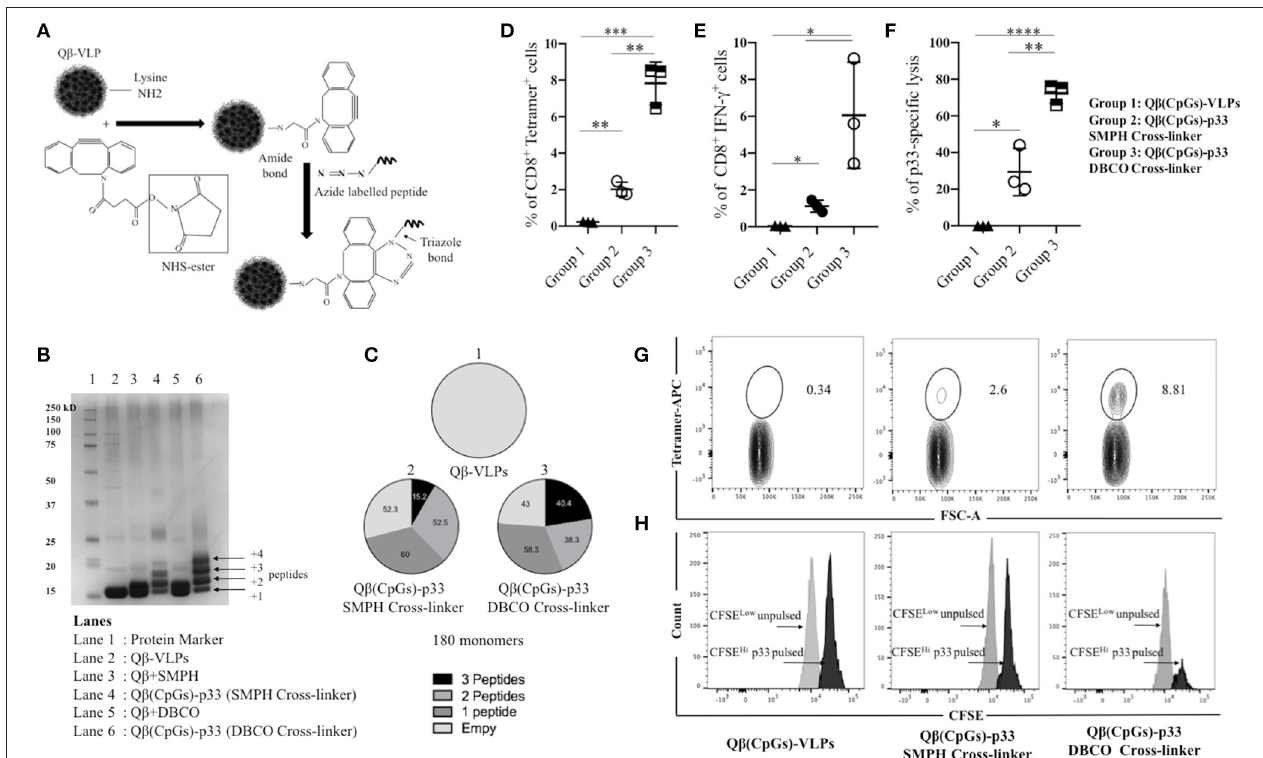
FIGURE 2 | Bio-orthogonal Cu-free click chemistry; an efficient method for coupling antigens to VLPs to enhance their immunogenicity. (A) A sketch illustrating the coupling method using Bio-orthogonal Cu-free click chemistry (dibenzocyclooctyne NHS ester DBCO). Briefly, NHS ester reacts with Lys residues on VLPs and incorporates a cyclooctyne moiety which reacts with the azide labeled molecule forming a stable triazole linkage. (B) SDS-PAGE stained with coomassie blue showing the coupling efficiency of p33 to Q β (CpGs)-VLP using SMPH cross-linker or DBCO cross-linker. Lane 1 protein marker, lane 2 Q β -VLP monomer, lane 3 Q β (CpGs)-VLP derivatized with SMPH cross-linker, lane 4 Q β (CpGs)-p33 vaccine using SMPH cross-linker, lane 5 Q β (CpGs)-VLP derivatized with DBCO cross-linker, lane 6 Q β (CpGs)-p33 vaccine using DBCO cross-linker. Each extra band in lanes 4 and 6 indicates a peptide binds to a Q β monomer. (C) Densitometric analysis of SDS-PAGE lanes 1, 4, and 6. (1) uncoupled Q β -VLP, total 180 monomers, (2) Q β (CpGs)-p33 vaccine using SMPH cross-linker, and (3) Q β (CpGs)-p33 vaccine using DBCO cross-linker. Notice the percentage of the coupled peptides to Q β -VLP monomers, total 180 monomers. (D) Percentage of CD8 + Tetramer + cells (means ± SEM) in the spleen of vaccinated groups: group 1) Q β (CpGs)-VLPs, group 2) Q β (CpGs)-p33 vaccine using SMPH cross-linker, and group 3) Q β (CpGs)-p33 vaccine using DBCO cross-linker. (E) Percentage of CD8 + IFN- γ + secreting cells (means ± SEM) in the spleen of vaccinated groups. (F) CFSE in vivo lytic activity in the spleen of vaccinated groups, using the formula 100X(1–CFSE Hi pulsed/CSFE Low un-pulsed). Statistical analysis by Students t -test. (G) Representative FACS plots showing the percentage of CD8 + Tetramer + cells in the spleen of vaccinated groups. (H) Representative FACS histogram of CFSE in vivo lytic activity in the spleen